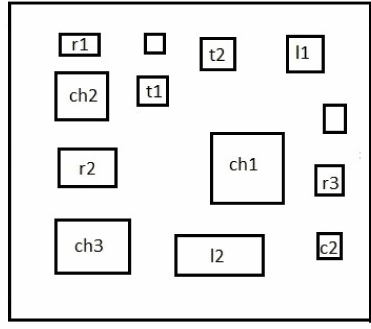
Figure 1. Workspace for manipulation